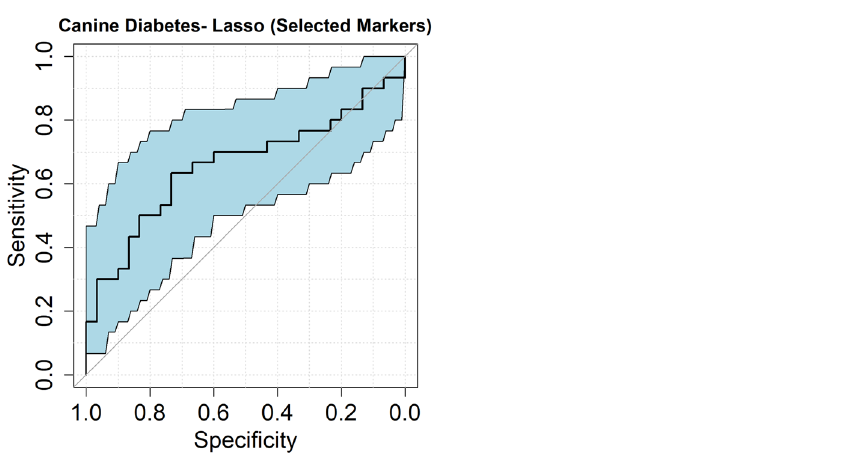
Figure 3. ROC curve. The antibody panel (Anti-KANK2, Anti-GLI1, Anti-SUMO2) was obtained from lasso logistic regression model with a sensitivity of 37% (95% CI 0.17–0.67%) at 90% specificity and an AUC of 0.66 (95% CI 0.52–0.80). The blue area represents the 95% CIs of sensitivities for each value of specificities, and the 45-degree straight line represents a useless biomarker having a sensitivity of 10% at 90% specificity and an AUC value of